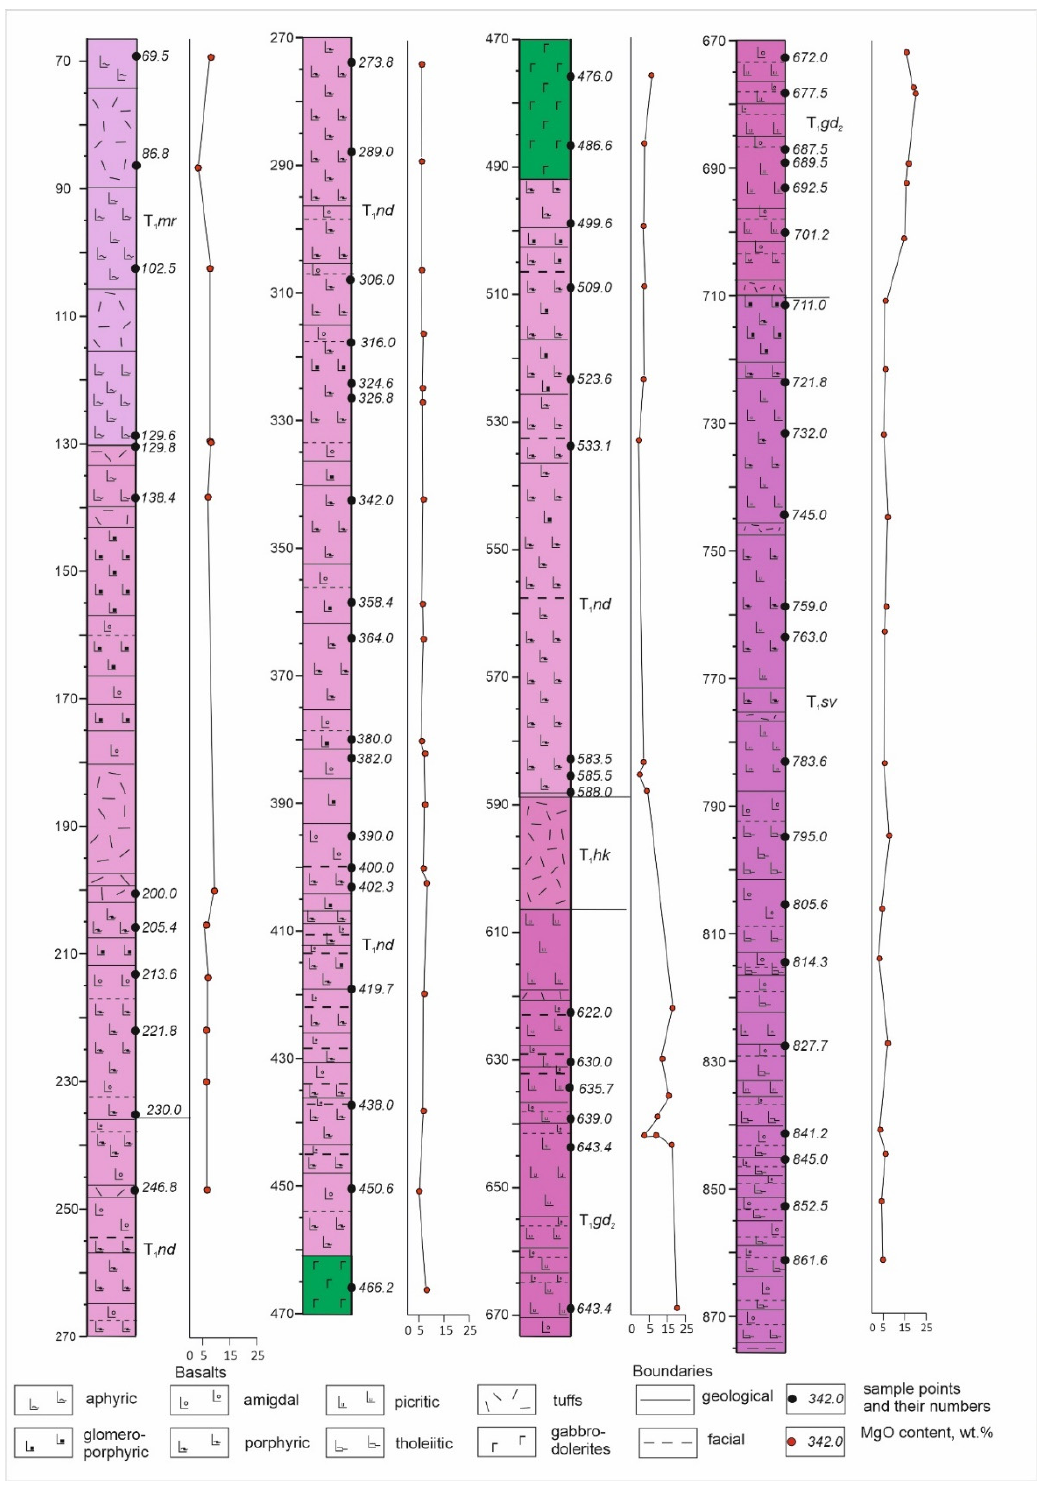
Figure 4. Volcanic section in the Vologochan syncline and MgO distribution in borehole OB ‐ 36. Formations (here and in Figures 5–7): P 3 iv Ivakinsky, T 1 sv Syverminsky, T 1 gd Gudchikhinksy, T 1 hk Khakanchansky , T 1 tk Tuklonsky, T 1 nd Nadezhdinsky, T 1 mr Morongovsky. Subscript indexes 1,2,3 mean lower, middle and upper subformations, respectively. Sample number is the depth in borehole OB ‐ 36, meters.